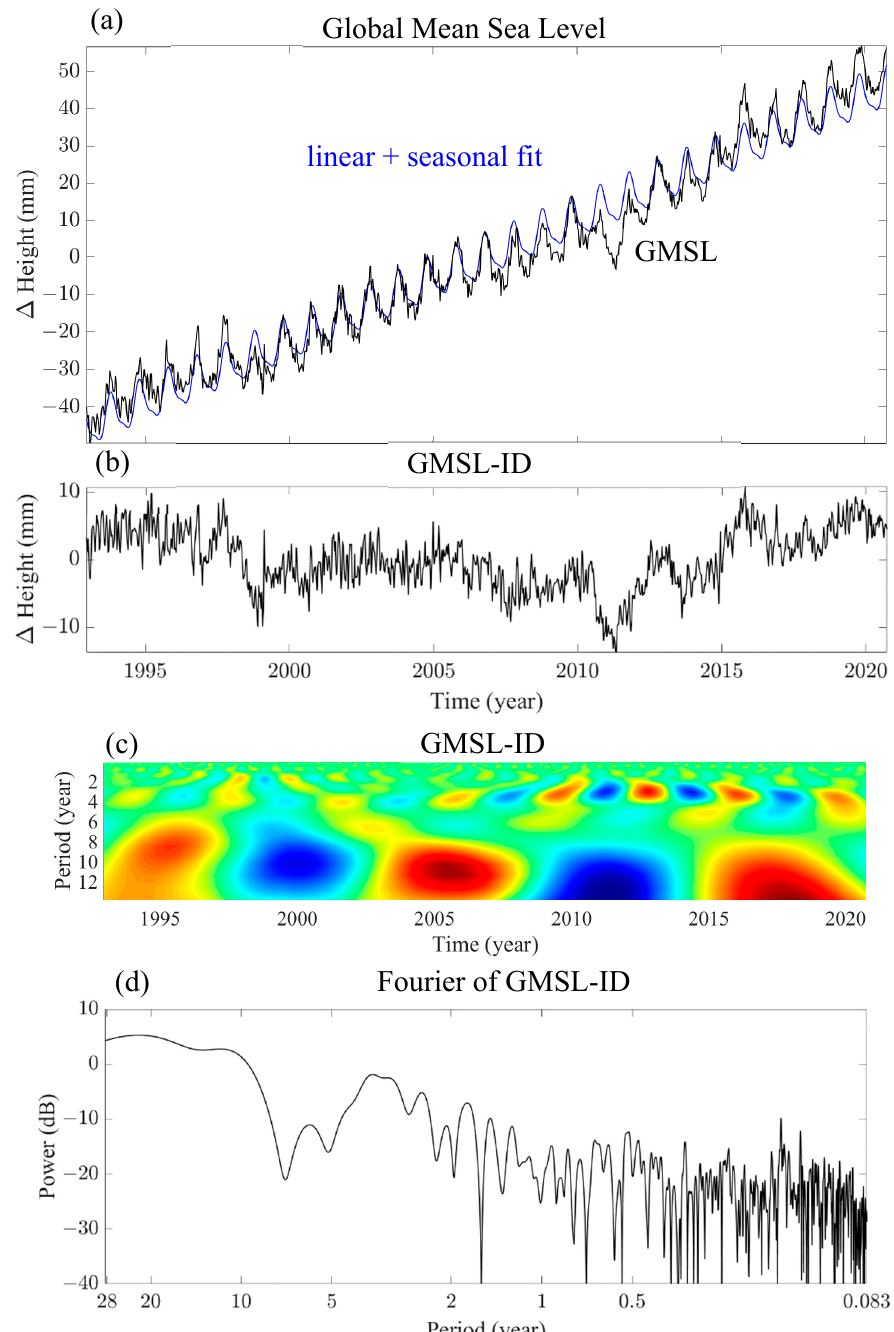
Figure 1. Time series of the altimetry-observed global mean sea level (GMSL), 1992.9–2020.75. ( a ) The original GMSL data (black) overlaid with the least-squares fit (blue) of a linear + seasonal (annual + semi-annual) terms. ( b ) The interannual–decadal GMSL-ID time series, i.e., the difference between the two curves in ( a ); note the different scales. ( c ) Time–frequency (real-valued) Morlet wavelet spectrum of GMSL-ID in ( b ) on the interannual–decadal timescale (where red indicates the undulation peaks and blue the troughs). ( d ) Fourier power spectrum of GMSL-ID, plotted as a function of logarithmic of frequency to accentuate the lower-frequency portion.